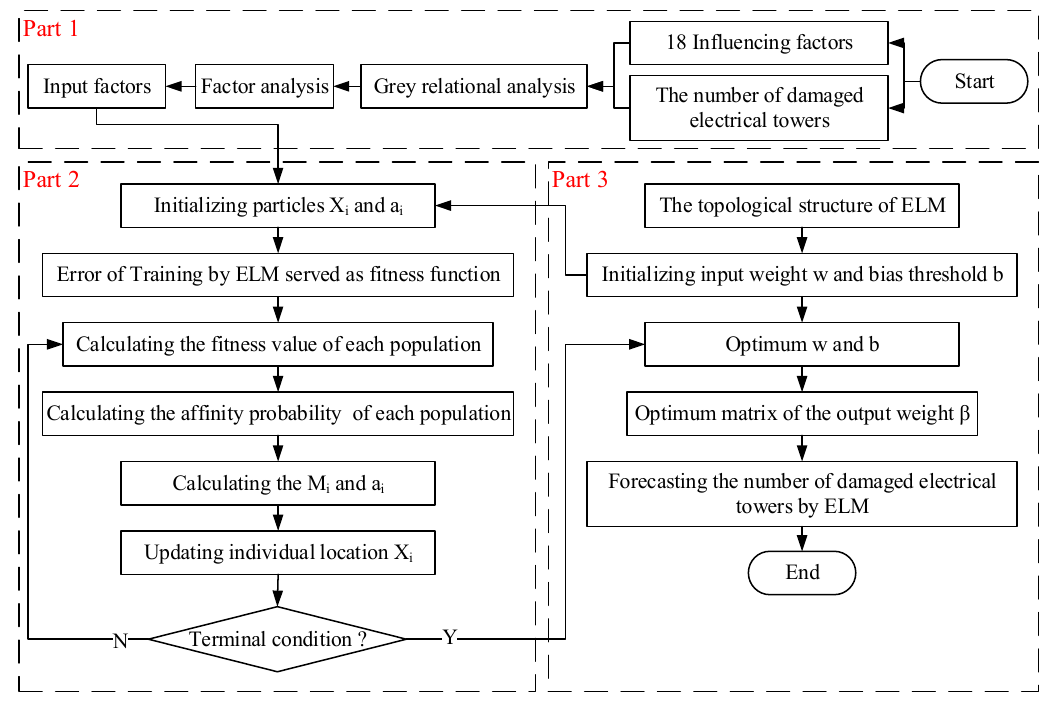
Figure 2. Flowchart of the IGSA-ELM model.